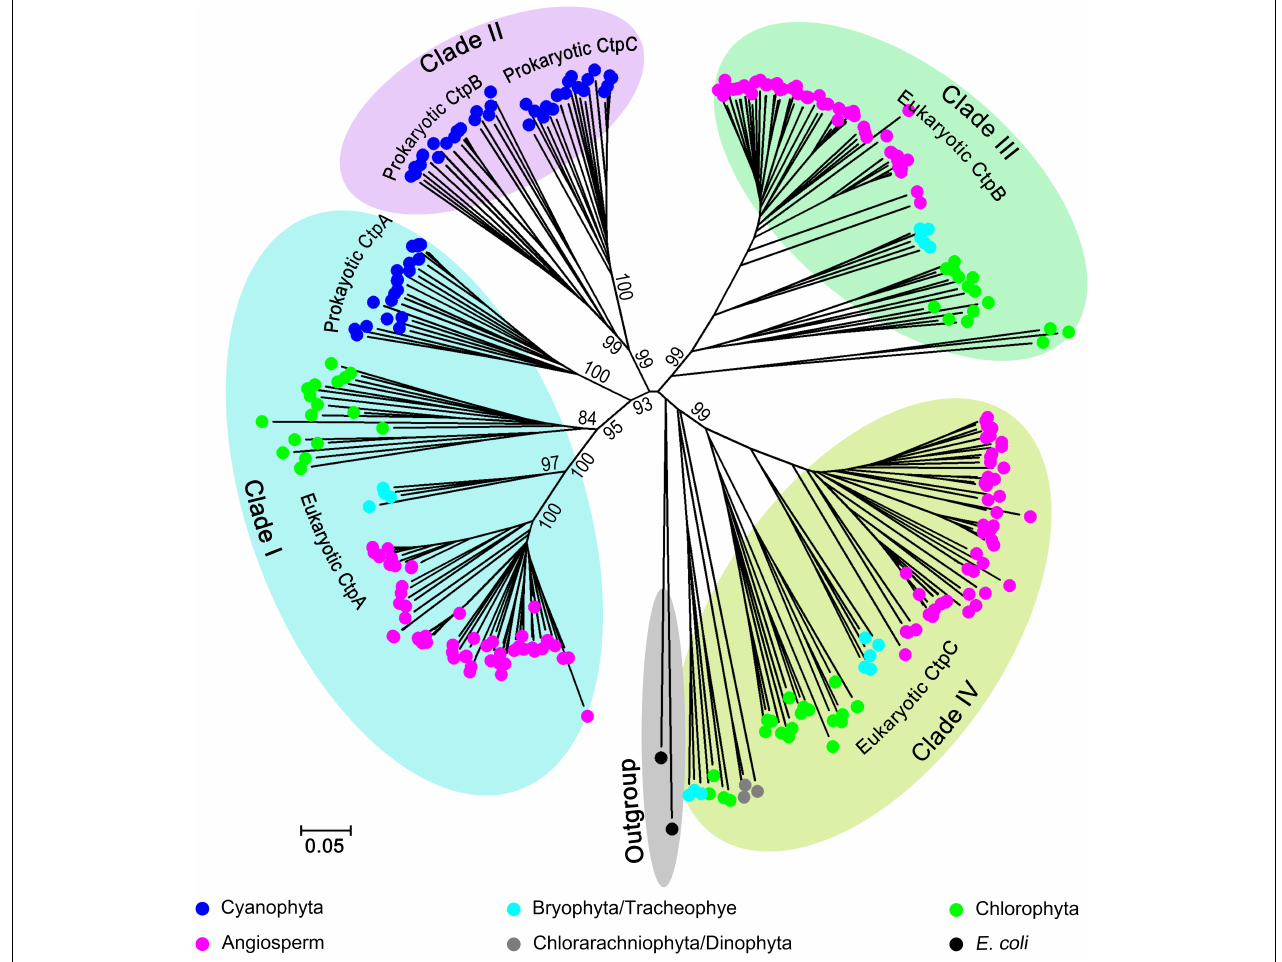
FIGURE 1 | Phylogenetic analysis of C-terminal peptidase (CTP) family. Two hundred and eighty-six Ctp proteins were retrieved from 93 oxygenic photosynthetic species, including Cyanophyta (20), Chlorophyta (18), Bryophyta (3), Tracheophyte (1), Angiosperms (49), Chlorarachniophyta (1), and Dinophyta (1). For the phylogenetic analysis, the polypeptide sequences were subjected to the multiple sequence alignment (MSA) analysis with ClustalW. The phylogenetic tree was constructed with MEGA6 base on the MSA profile using the Neighbor-Joining method (Saitou and Nei, 1987) and a 1,000 bootstrap resampling value (Felsenstein, 1985). Two tsp proteins from Escherichia coli were used as the